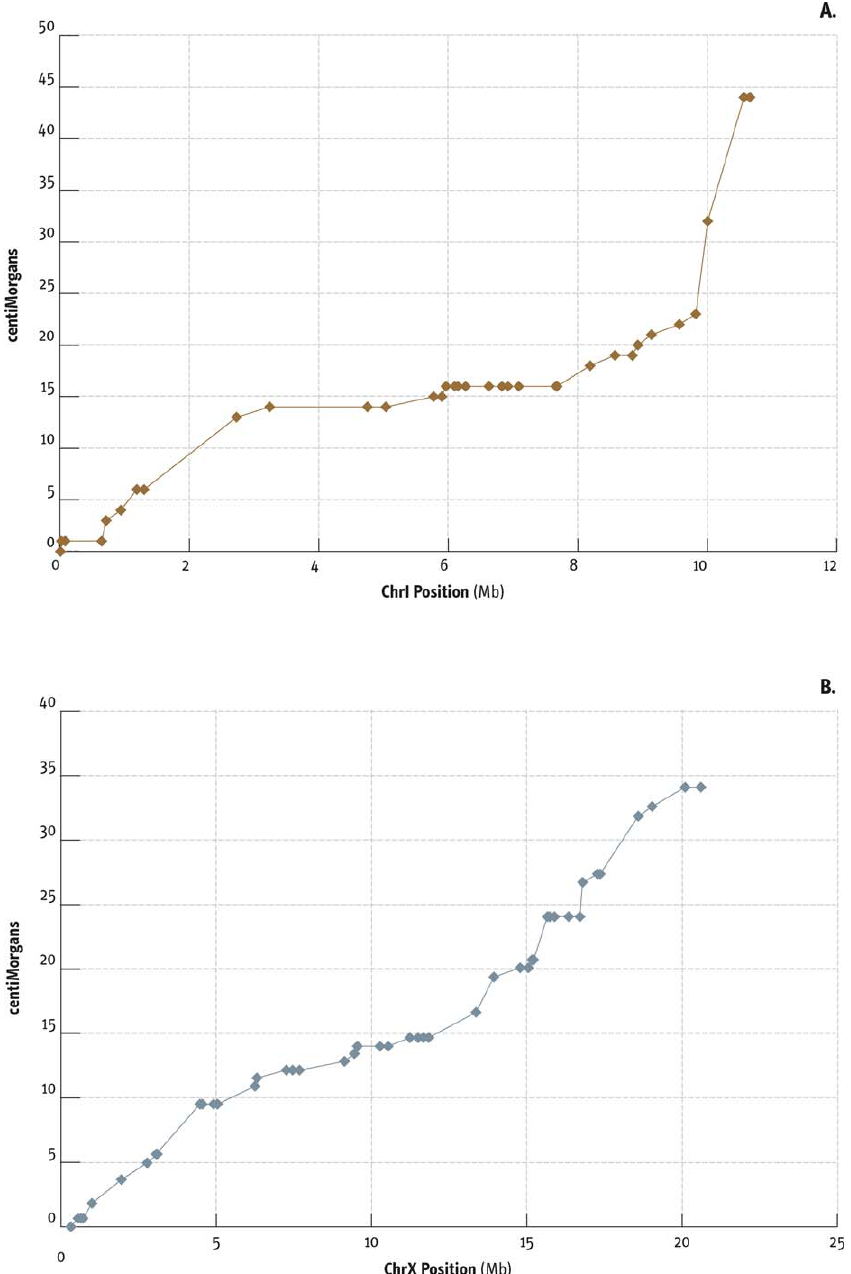
Figure 3. Recombination and Physical Distance in C. briggsae The panels show Marey plots [16] for chromosomes CbI (A) and CbX (B) in which the position in cM is plotted against the sequence position for each SNP marker. Recombination is high on the arms of CbI and low in the center. Other autosomes broadly follow this pattern (Figure S4). The difference between arms and centers on CbX is less marked.